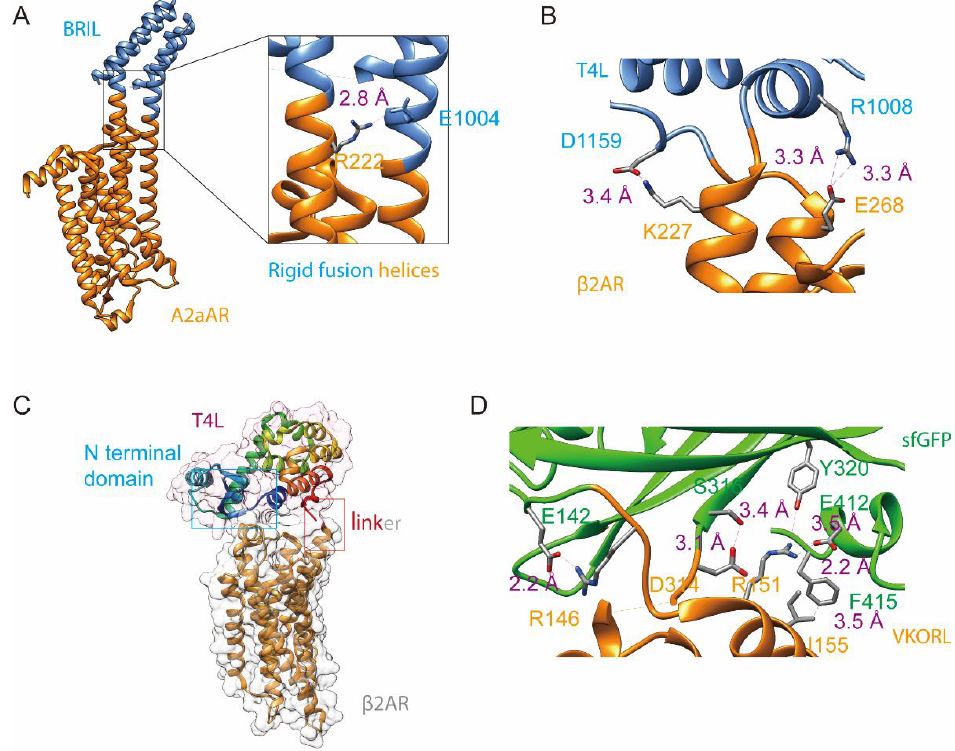
Figure 3. Apart from the linker connection, various interactions can form to stabilize the conformation of the fusion protein. ( A ) Structure of insertion fused BRIL with human A (2A) adenosine receptor (A2aAR-BRIL, PDB 4EIY). Helical connections are formed at the two linker regions between BRIL and A2aAR. Inset, salt bridge is formed between the E1004 from BRIL and R222 from the A2aAR. ( B ) Structure of insertion fused β2AR-T4L (PDB 2RH1). Designed helical connection is not formed. Salt bridges are formed between T4L R1008 and β2AR E268, and between T4L D1159 and β2AR K227. ( C ) Structure of T4L fused to the N-terminus of β2AR (PDB 4GBR). The surface of T4L is shown in light pink and that of β2AR in grey. ( D ) Structure of termini restrained sfGFP-VKOR-like (PDB 6WVI). Many interactions are formed between the fused sfGFP and VKORL (see description in text). For insertion fusion of β 2AR with T4L ( β 2AR-T4L, PDB:2RH1) [17] (Figure 3B),